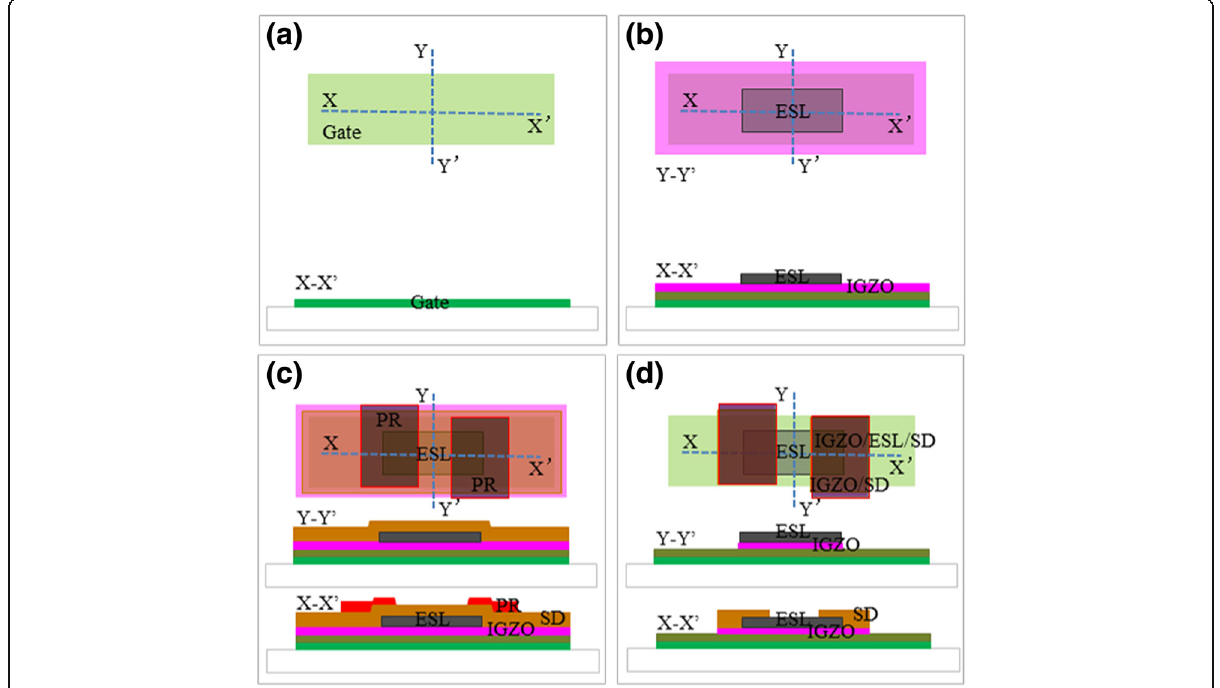
Fig. 2 (Color online) Schematics of simultaneous formation method for TFT channel and S/D electrode in CL-ES process. a The first step that forms gate electrode. b The second step that forms etch-stopper layer. c The third step that forms S/D photo pattern. d The fourth step that forms S/D electrode and active pattern